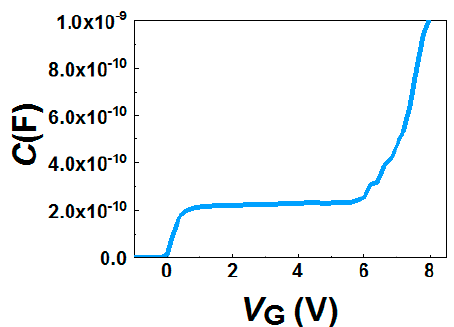
Figure 8. Capacitance-Voltage (CV) measurement in the device with 3 nm remaining bottom Al 0.15 Ga 0.85 N barrier.